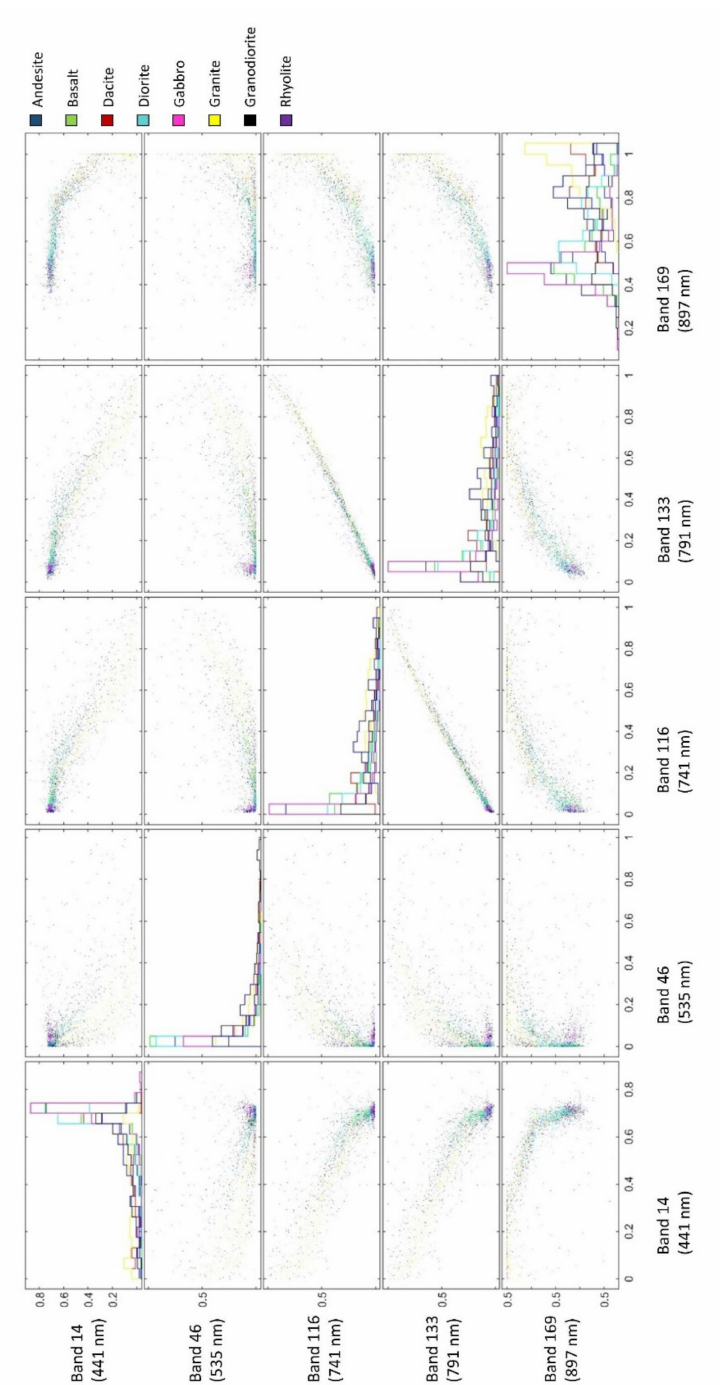
Figure 7. Projection of complex rock hyperspectral signature data points in dimensionality reduced (via Neighbourhood Component Analysis feature selection) 2D planes showing the relative reflectance spectral strength relationships between five different spectral bands for eight rock